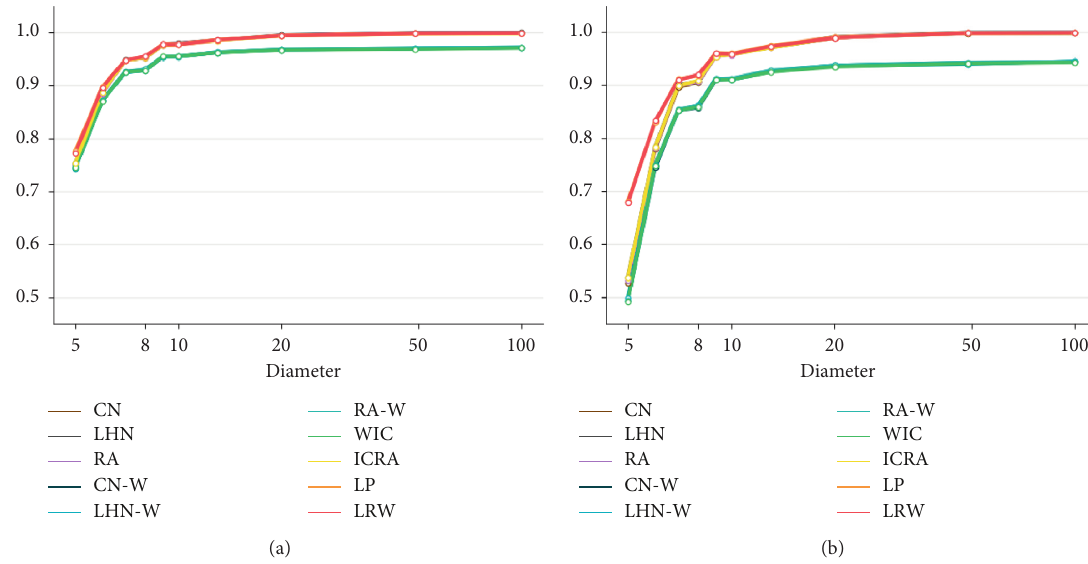
Figure 11: Performance of each predictor under AUC and W-index in WS-Group6. (a) Accuracy measured by AUC. (b) Accuracy measured by